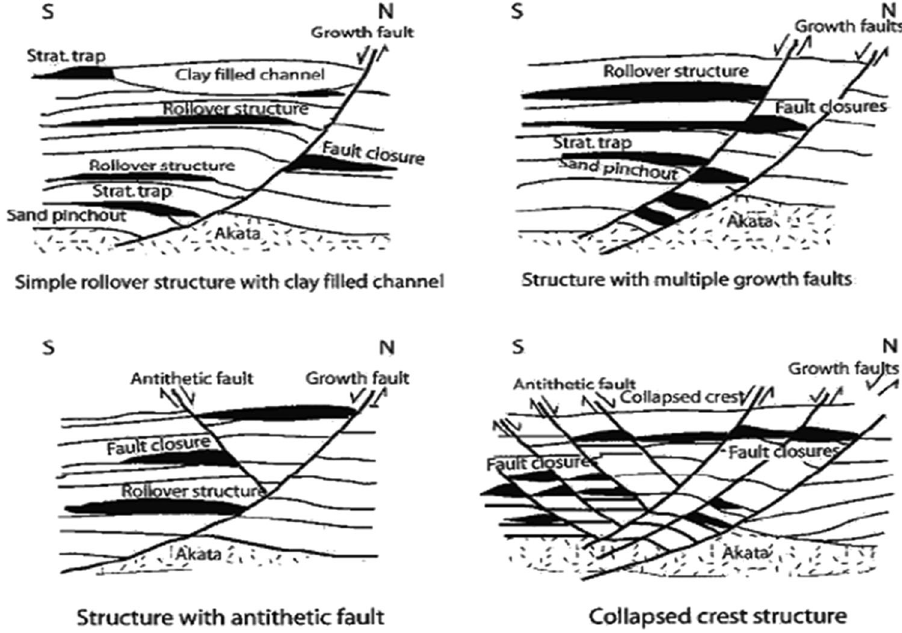
Fig. 2 Niger Delta oil field structures and associated traps (Stacher